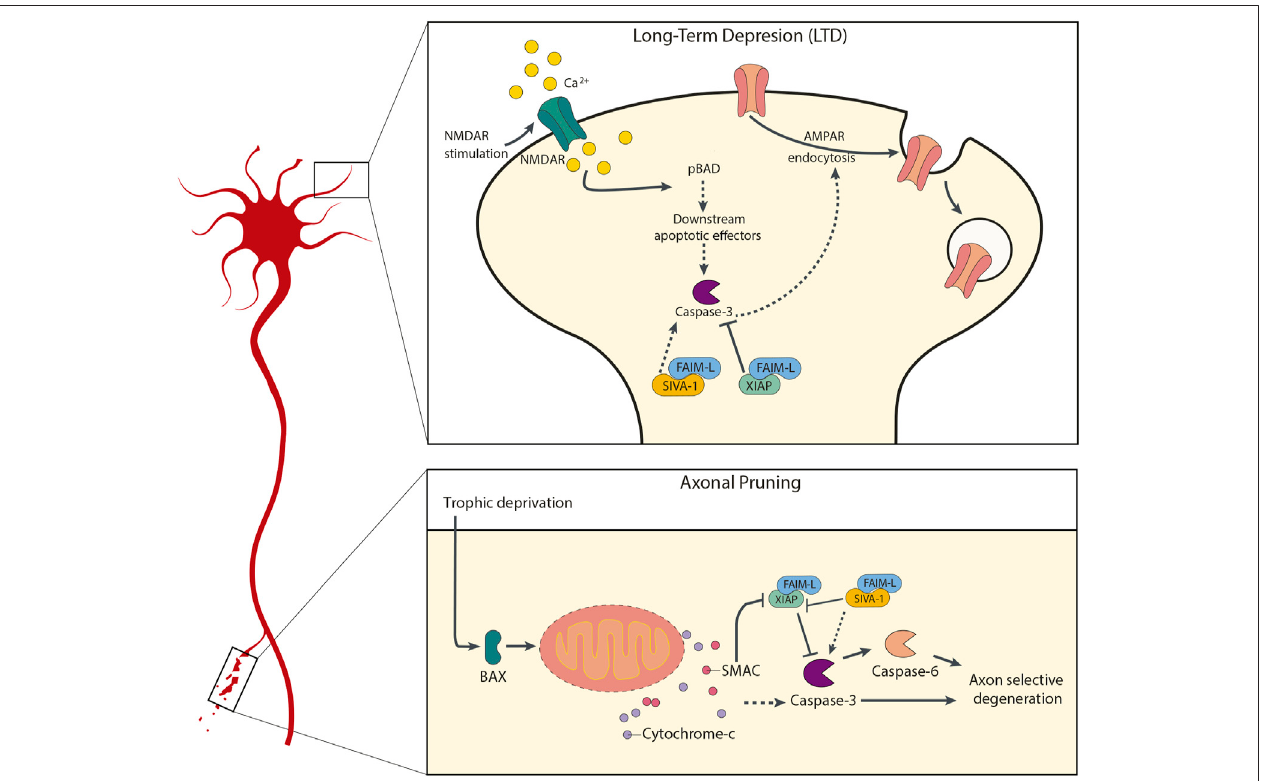
FIGURE 1 | Participation of FAIM-L and SIVA-1 in neuronal plasticity processes. The upper panel diagram represents the molecular mechanism by which FAIM-L andSIVA-1areinvolvedinAMPAreceptorsinternalizationduringLTDprocessesinsynapticplasticity,inresponsetoNMDAstimulation.ThemaintenanceofXIAP-FAIM- L interaction would allow XIAP-mediated caspase-3 inhibition, and therefore prevent the caspase-3-dependent AMPA receptors internalization; a displacement of this interaction mediated by SIVA-1 binding to FAIM-L would allow the activation of caspase-3 and its consequent LTD induction and synaptic weakening. The lower panel diagram shows the similar role of FAIM-L and SIVA-1 in axonal pruning, as in trophic factors deprivation. In this case, an upstream activation of the mitochondrial apoptoticmachinerywould convergeintheactivationofcaspase-3,whoseactivity wouldberegulatedbythebalancebetweenSIVA-1-FAIM-LorXIAP-FAIM-Lbinding.